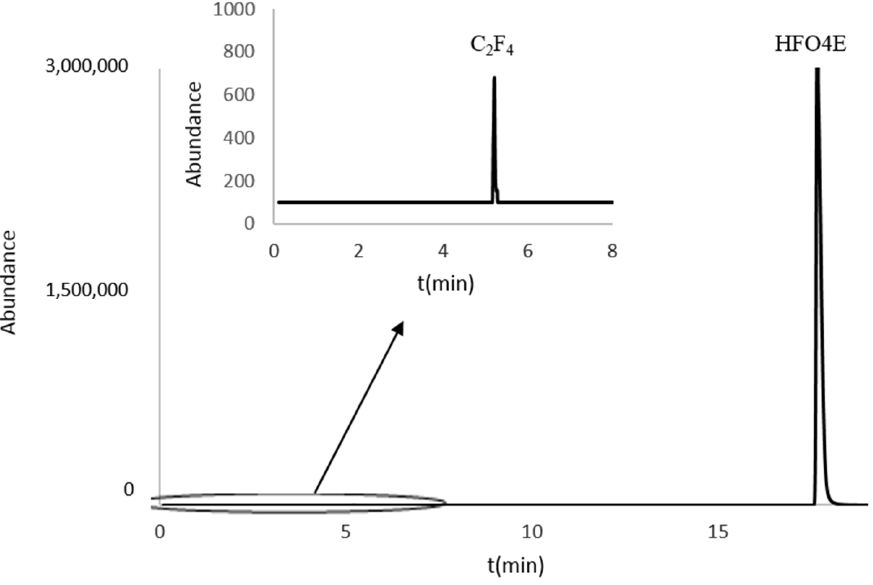
Figure 4. GC/MS chromatogram obtained for 21.7% ( v / v ) of HFO4E with N 2 , after dielectric tests at 24 kV level.